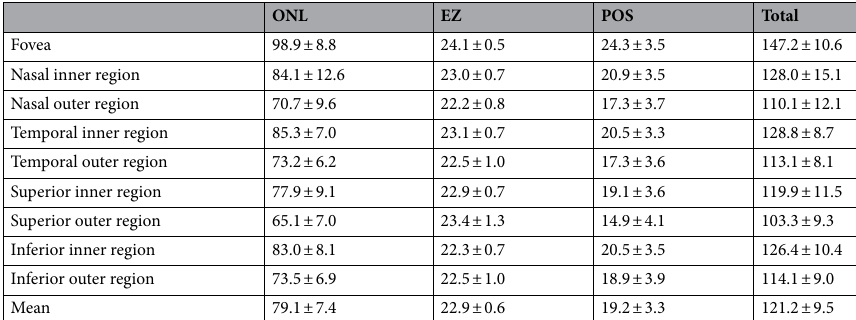
Table 1. Thickness of the retinal outer nuclear layer (ONL), the ellipsoid zone (EZ), the photoreceptor outer segment band (POS) and the total of all three structures in 9 Early Treatment Diabetic Retinopathy Study (ETDRS) subfields, in normal participants from the Beijing Eye Study. Data are presented as mean ± standard deviation